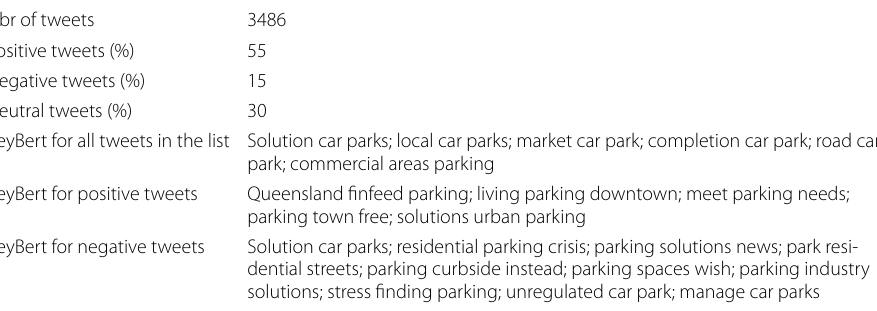
Table 3 Analysis of tweets with likes and favorites Nbr of tweets 3486 Positive tweets (%)